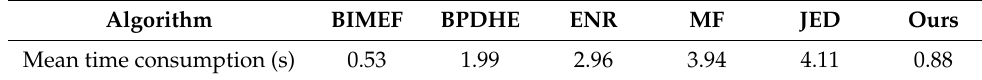
Table 3. Comparison of time consumption of the six algorithms.